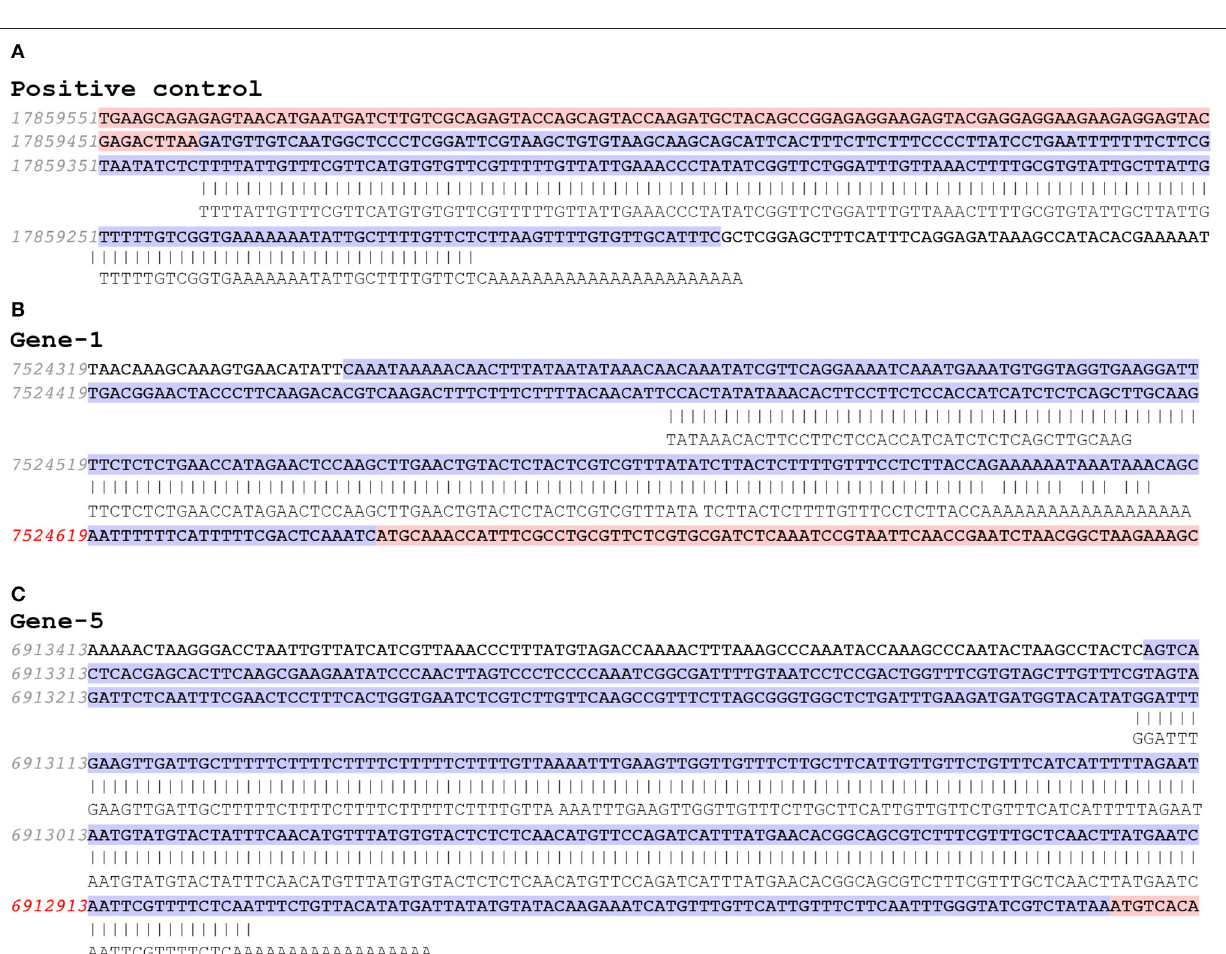
Frontiers in Plant Science |